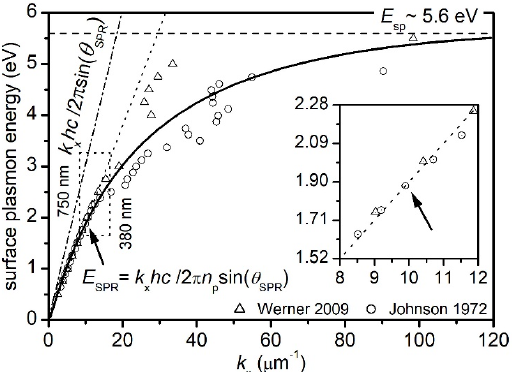
Figure 2. The SPR was designed based on the properties of the materials used in the fabrication of the MSPRS. The incident wavelength is of interest in studying the MSPRS resonance [27]: ( , ) the surface plasmons (SPs) dispersion relation in Au using experimental relative permittivity data from Johnson et al. [37], Werner et al. [38], and the calculations from Raether [6]; ( continuous line ) an idealized SP dispersion relation; ( dotted line ) the dispersion relation of p-polarized, 660-nm photons propagating through a polystyrene prism ( ε p = 2.55) reaching resonance at θ SPR = 40.58 ◦ ; and ( dash-dotted line ) dispersion relation of the same photons at the same angle of incidence, but no prism ( ε p = 1.00); ( dotted box ) the location of the visible spectrum, marked in wavelength units; ( long-dashed horizontal line ) the SP energy at large wave vectors. The arrows point at the SPR condition for the generation of a surface plasmon polariton (SPP) when the energy of the 660-nm photons travelling through a prism at the right angle of incidence ( θ SPR ) excites a SP at the air / Au interface; ( insert ) Magnified view around the point of SP